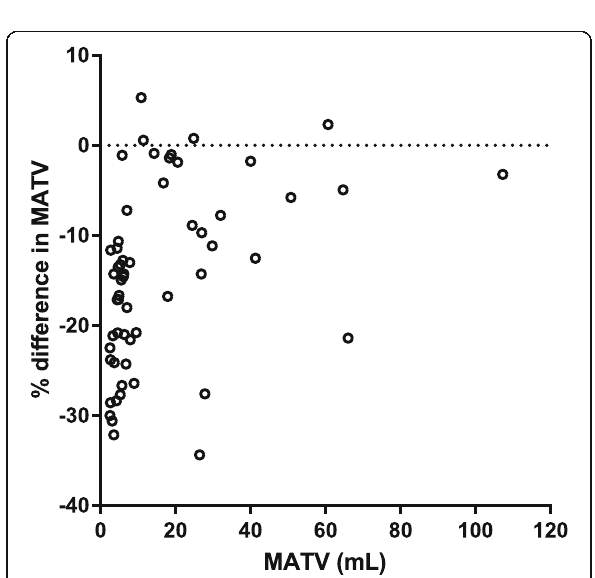
Fig. 2 Relative change (%) in quantitative parameters after PVC (LR) as a function of lesion MATV (mL) for V T ( a ), K 1 ( b ), BP ( c ), and SUV ( d ). TBR is not displayed since it was virtually identical to SUV